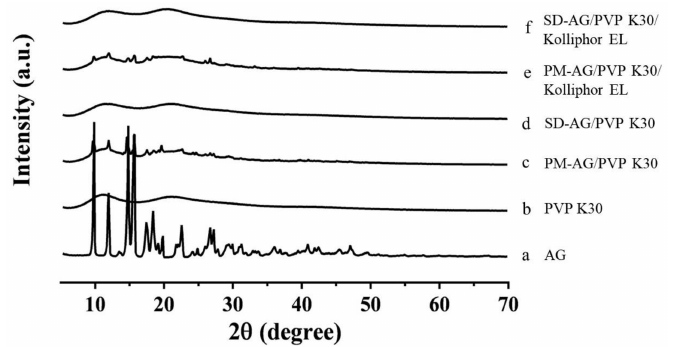
Figure 3. Powder x-ray di ff raction patterns of: ( a ) andrographolide (AG); ( b ) PVP K30; ( c ) physical mixture (PM)-AG / PVP K30 (1:7, w / w ); ( d ) solid dispersion (SD)-AG / PVP K30 (1:7, w / w ); ( e ) PM-AG / PVP K30 / Kolliphor EL (1:7:1, w / w / w ); and ( f ) SD-AG / PVP K30 / Kolliphor EL (1:7:1, w / w / w